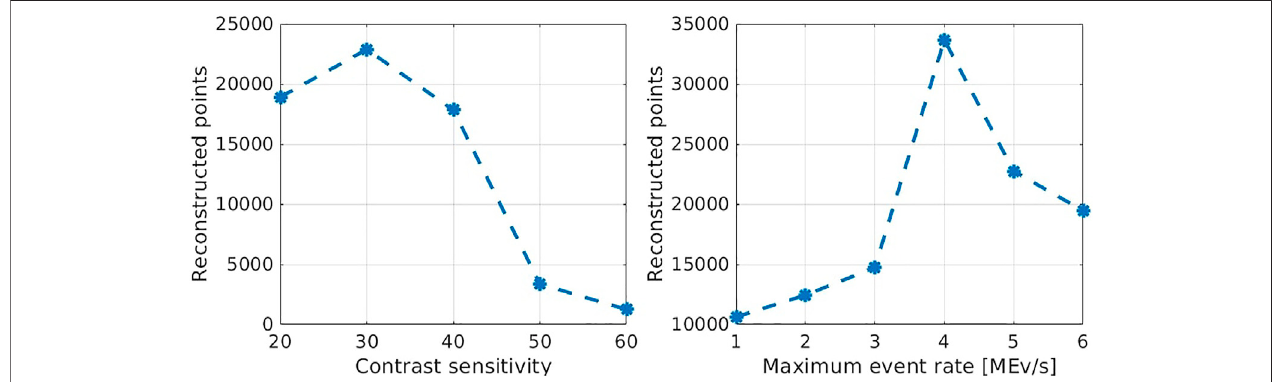
FIGURE 5 | Number of reconstructed points in different experiments with different camera settings. On the left, the experiments have been carried out with a maximum event rate of 5 MEv/s and varying contrast sensitivities. On the right, a fi xed contrast sensitivity of 30 and varying maximum event rates were used. For each data point represents the mean value of fi ve